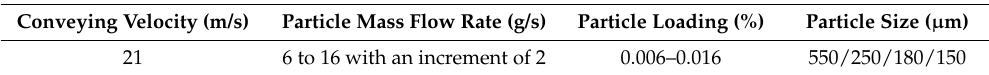
Table 1. Experimental test conditions.